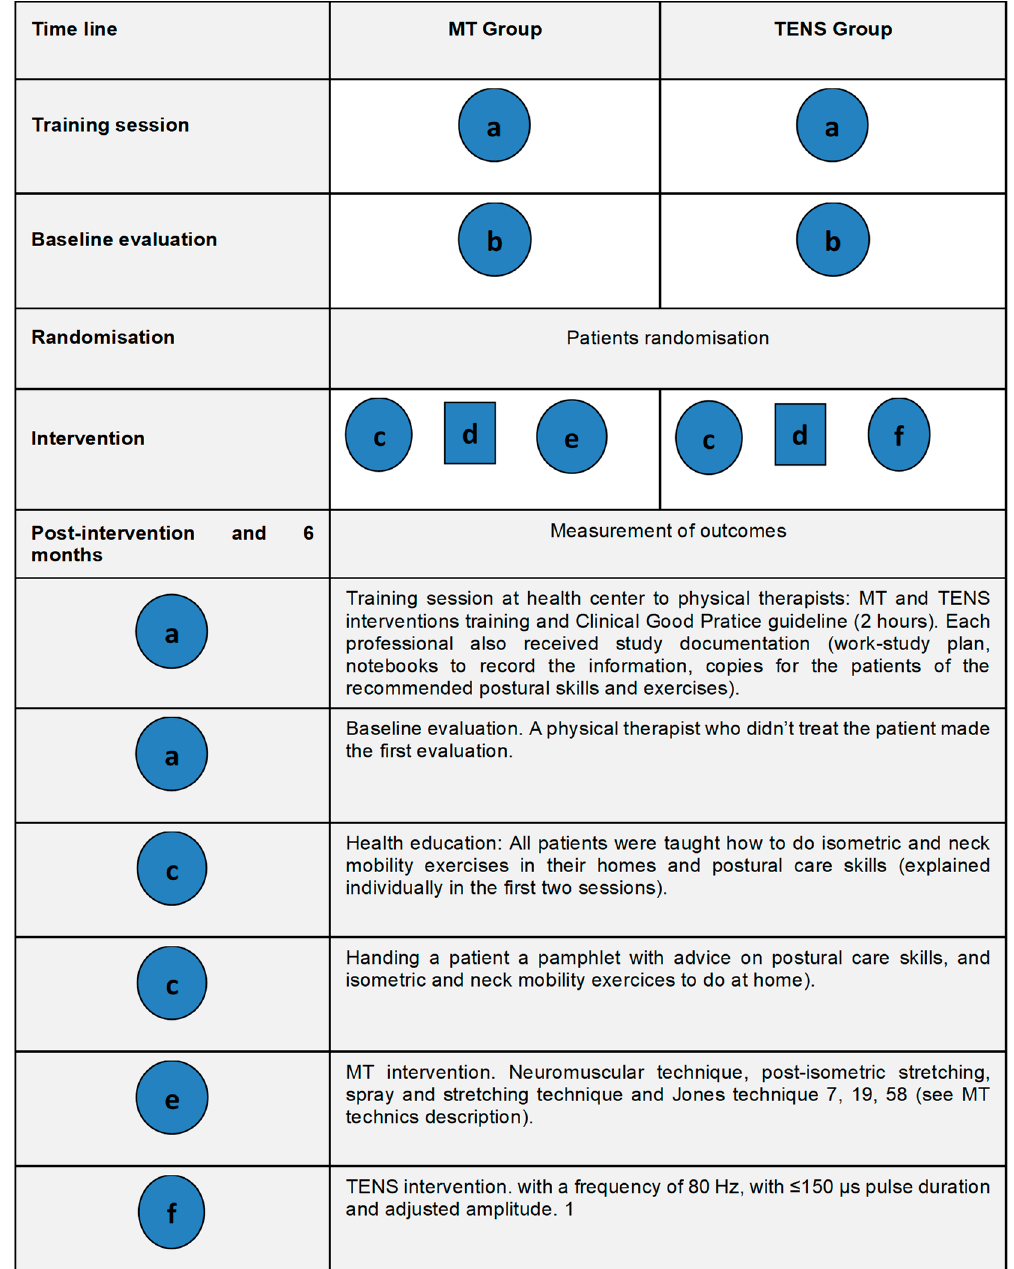
Figure 1. Graphical depiction of MT and TENS interventions. MT: Manual therapy; TENS: transcutaneous electrical nerve stimulation.